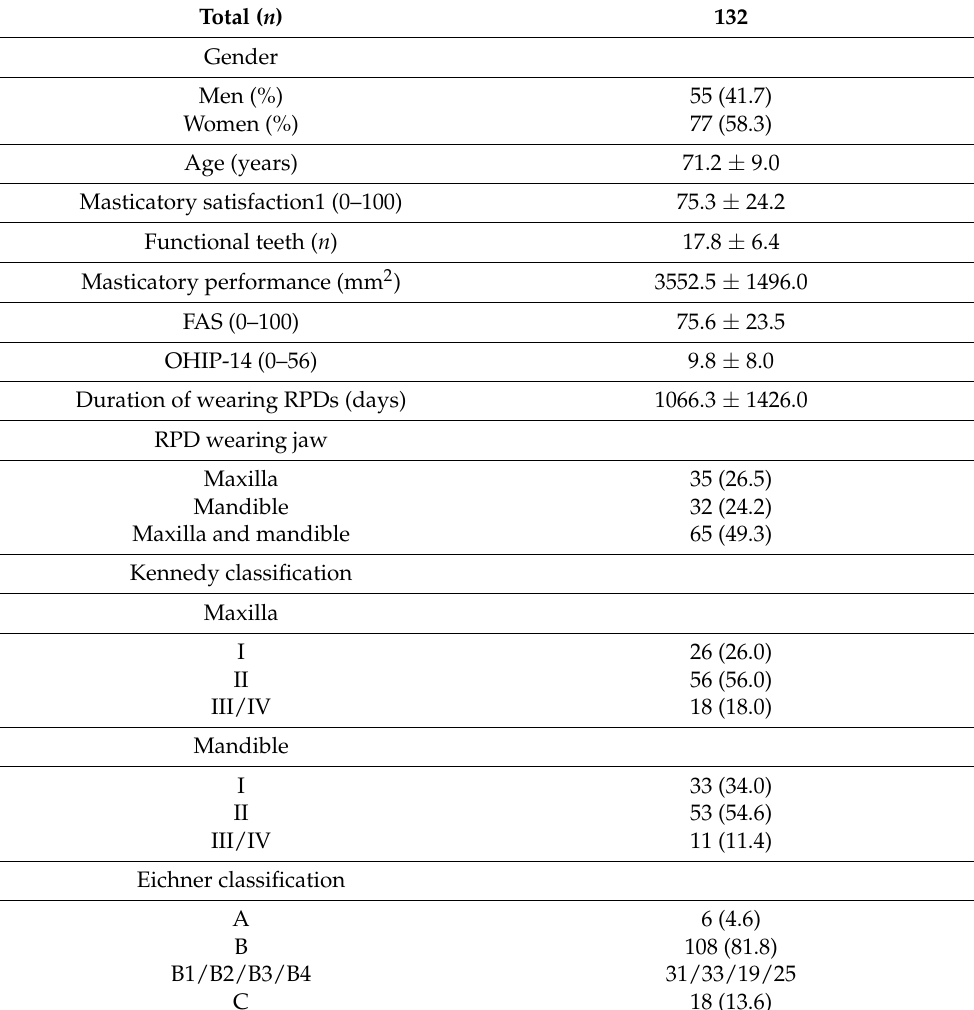
Table 3. Participant